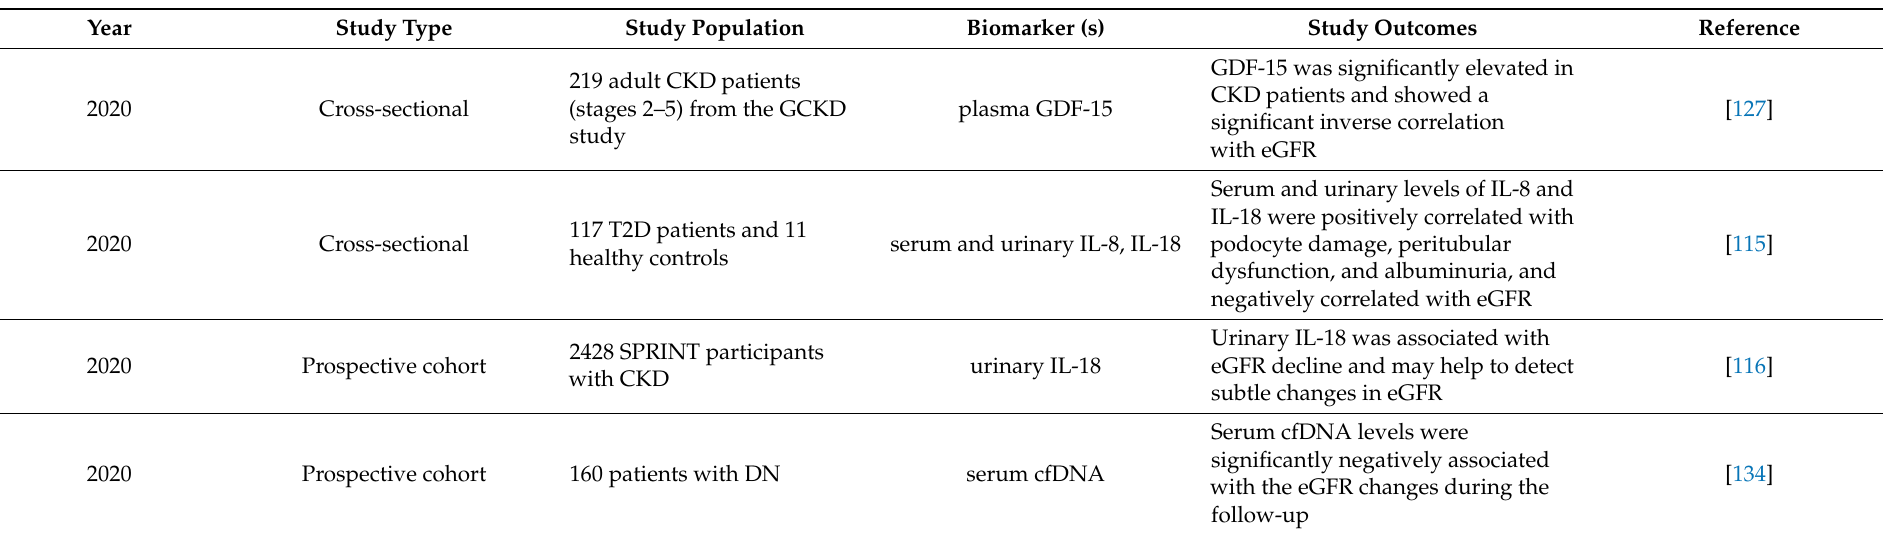
Table 4. Research studies on biomarkers of inflammation and main outcomes in CKD